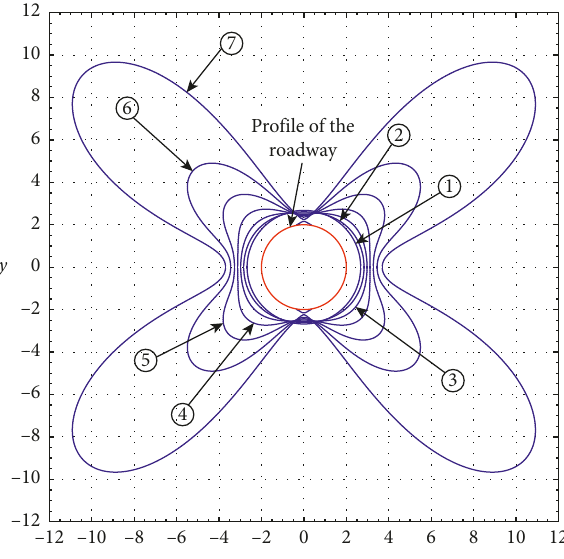
Figure 10: The geometrical morphology of the plastic